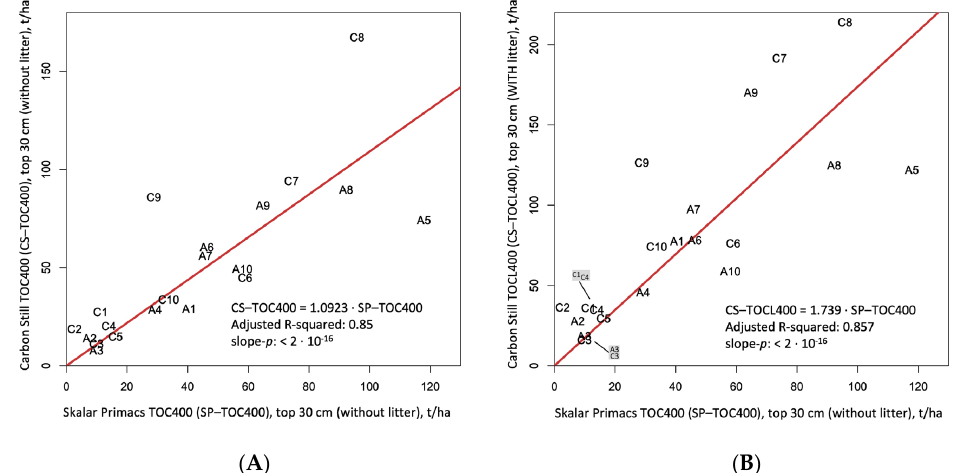
Figure 10. ( A ) Linear regressions between organic carbon estimated in organic mineral soil samples with Carbon Still (CS–TOC400) and Skalar Primacs (SP–TOC400). ( B ) Linear regressions between organic carbon estimated in organic mineral soil plus in litter samples with Carbon Still (CS–TOCL400) and organic carbon estimated in organic mineral soil samples with Skalar Primacs (SP–TOC400). Sliding from left to right on the graphs you go from the beach into the forest at the two sites (A = Albarella; C = Caleri): 1–2 = beach; 3–4 = dune; 5–6 = shrubland; 7–8 = forest; 9–10 = other (two humid areas in Caleri; flower bed, and new plantation in Albarella). 2. In Figure 11: